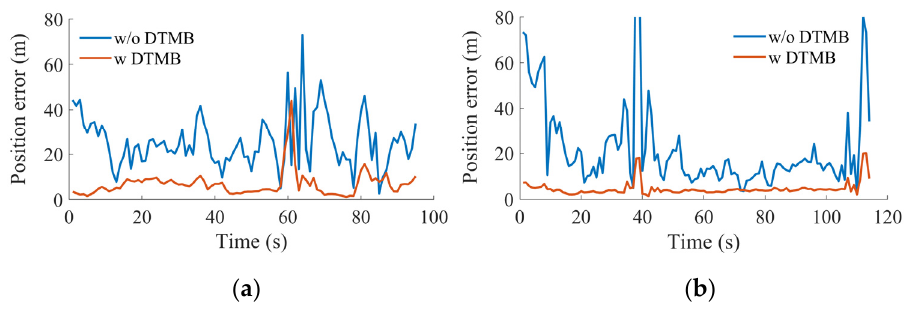
Figure 18. Position error time series when 4 satellites are visible. ( a ) Clockwise. ( b ) Counter-clockwise.